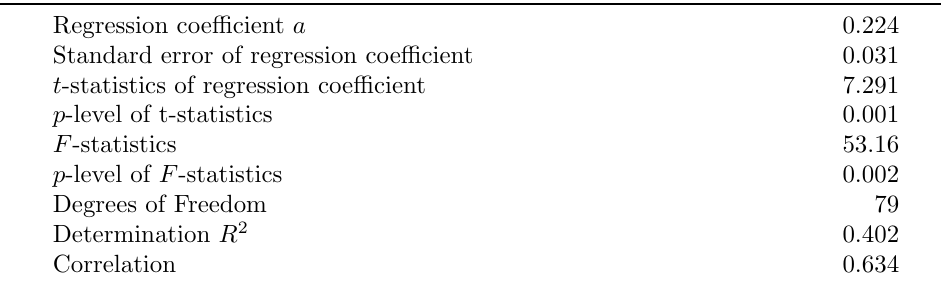
Figure 8: Average values of share of companies implementing energy efficiency innovations by groups of regions with different volumes of domestic R&D financing Table 6: Statistical characteristics of regression